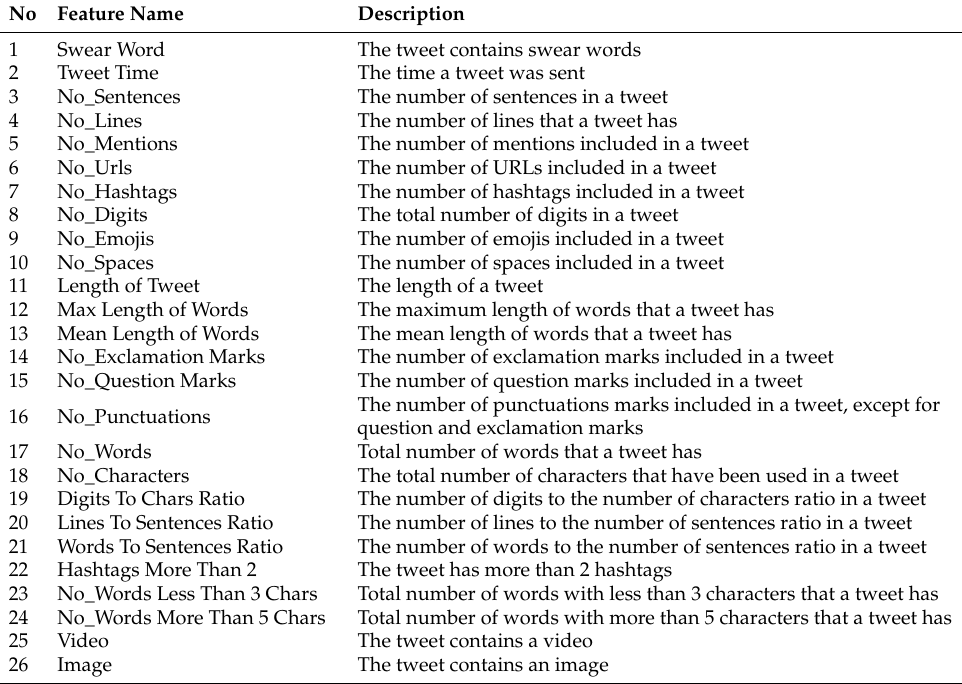
Table 2. Text-based features used in the study.